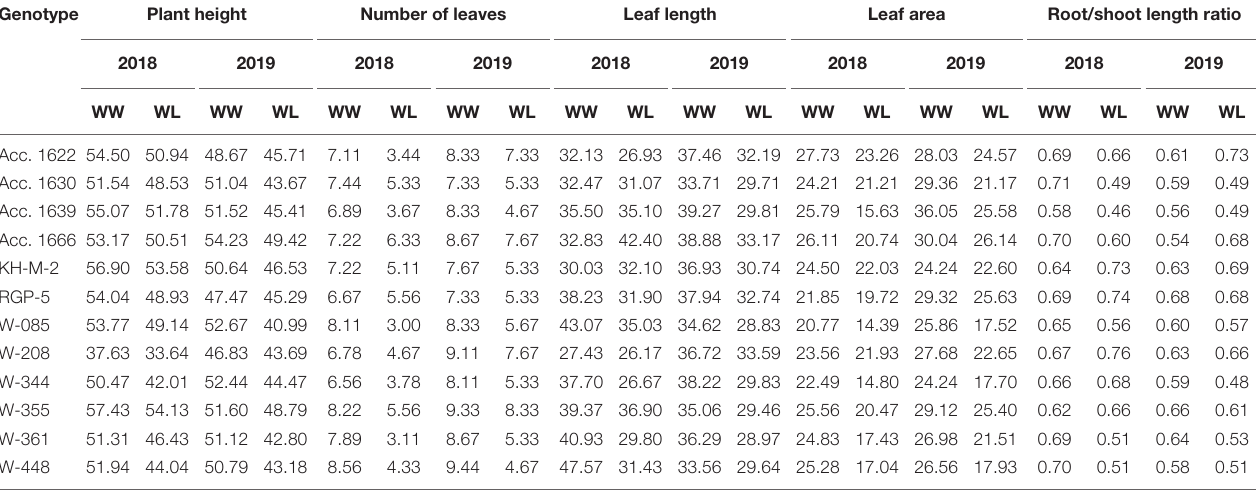
TABLE 5 | Phenotypic and yield traits of contrasting onion genotypes evaluated under well-watered and waterlogging conditions. Genotype Plant height Number of leaves Leaf length Leaf